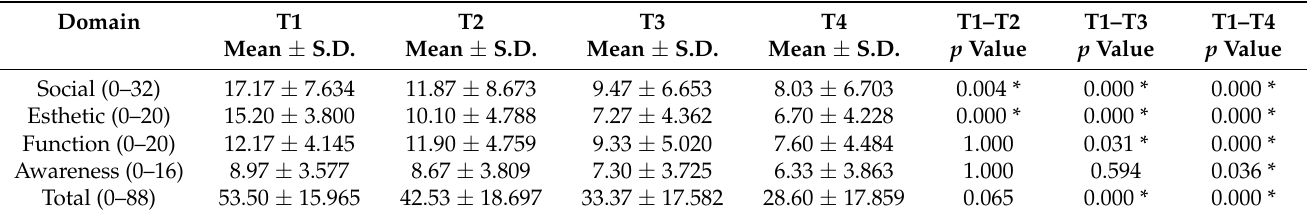
Table 2. The OQLQ score (total and subdomain) at each stage of the OFA group, compared using the Friedman and post hoc Dunn tests.